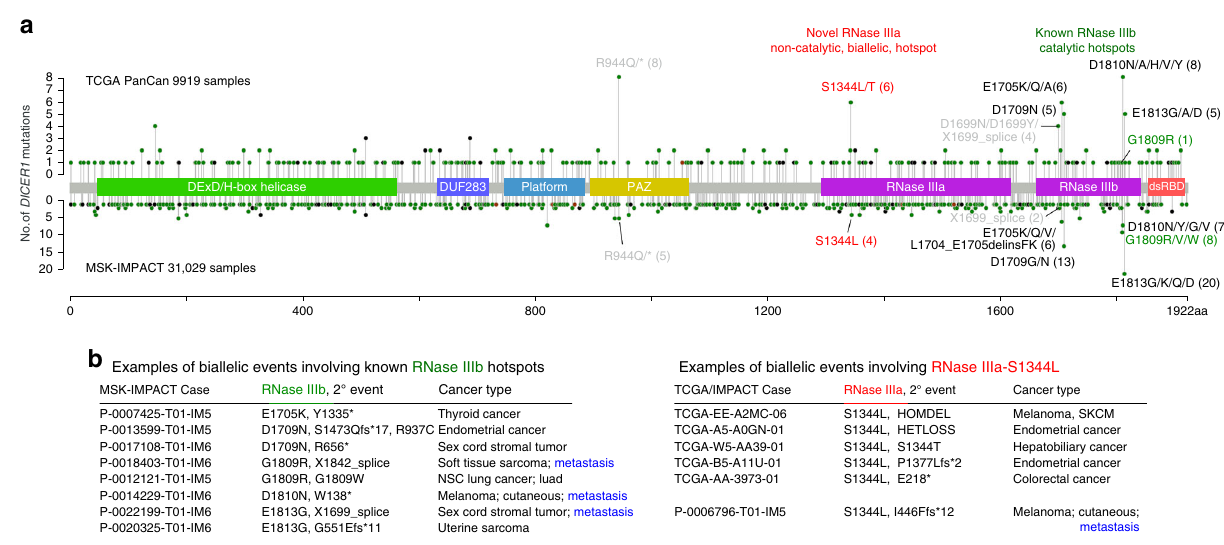
Fig. 1 Survey of DICER1 cancer mutations reveals recurrent RNase IIIb and IIIa hotspots. a Lollipop mutation diagrams of TCGA-PanCan (pointing up) and MSK-IMPACT (pointing down) datasets. The sites labeled in black designate mutations in the four catalytic residues in the RNase IIIb domain (D1709, E1705, E1813, D1810, in black) and an adjacent residue (G1809, in green) that are the major known biallelic DICER1 events in cancer. These aggregate data also reveal an uncharacterized biallelic alteration involving S1344L (in red) in the RNase IIIa domain. The background of other somatic mutations of unknown functional signi fi cance is shown for perspective; certain other apparently recurrent mutations are recovered in both TCGA and IMPACT datasets (e.g., PAZ-R944Q, in gray), but were not associated with biallelic hits in non-hypermutated samples. b Left column, examples of biallelic hits in each of the fi ve known RNase IIIb hotspot residues in IMPACT data, with their corresponding secondary inactivating mutations and cancer types. Right column, a selection of multiple cancer types that exhibit RNase IIIa-S1344L and carry diverse secondary inactivating mutations across TCGA and IMPACT data. Patient sequencing from metastatic tumors are noted (in